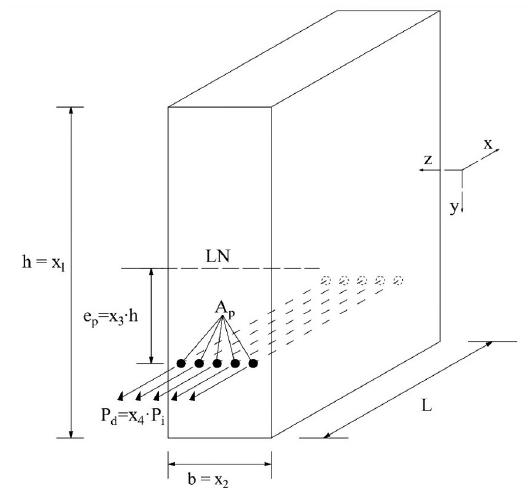
Figure 3. Cross-section of the analyzed